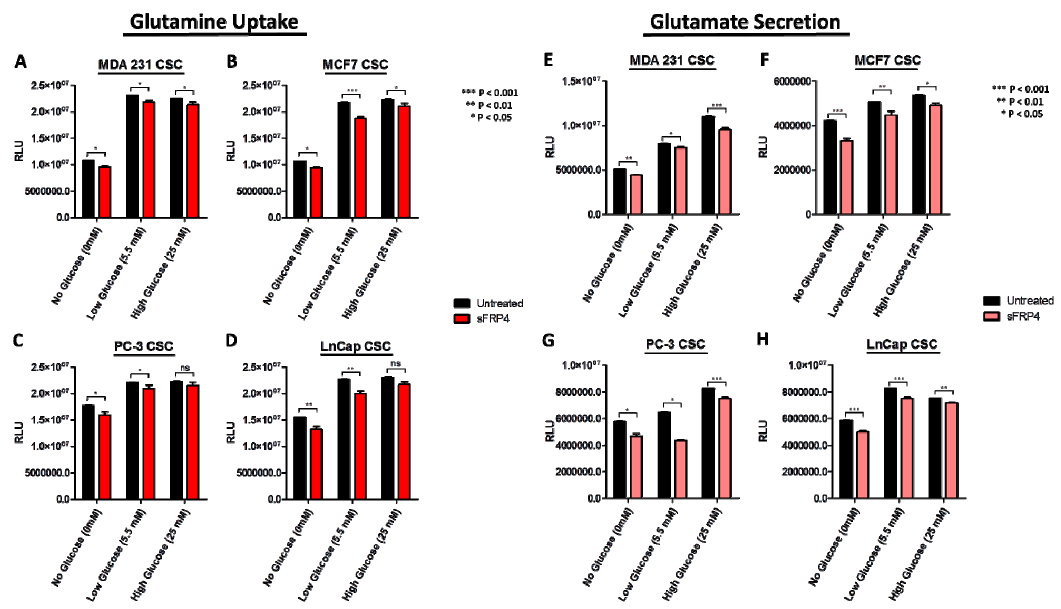
Figure 5. Extracellular metabolites with sFRP4 treatment of CSCs: Changes in glutamine uptake and glutamate secretion in CSCs grown in culture medium with increasing glucose concentrations were measured. ( A , E ) MDA231 CSCs; ( B , F ) MCF7 CSCs; ( C , G ) PC-3 CSCs; and ( D , H ) LnCap CSCs were treated with sFRP4 for 24 h. Statistical analysis was performed using ANOVA for analysis variance with Bonferroni test for comparison showing significance as *** p < 0.001; ** p < 0.01; * p < 0.05. Data are mean ± standard error of mean from three independent experiments.